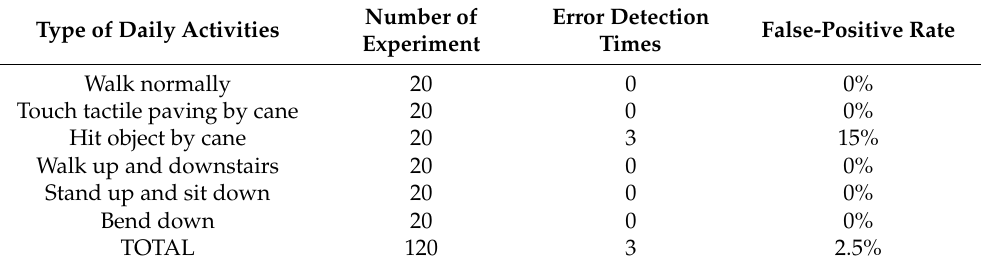
Table 3. False-Positive Rate of daily activities.